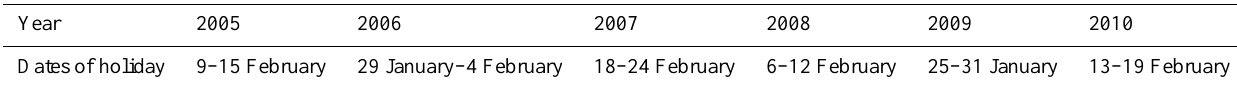
Table 1. Officially recommended holidays associated with Chinese New